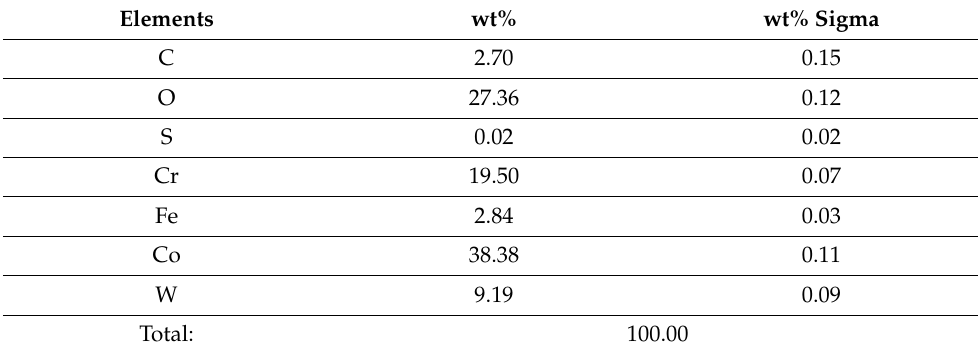
Table 6. Quantitatively determined values of the elements at the surface of sample 15-O3.